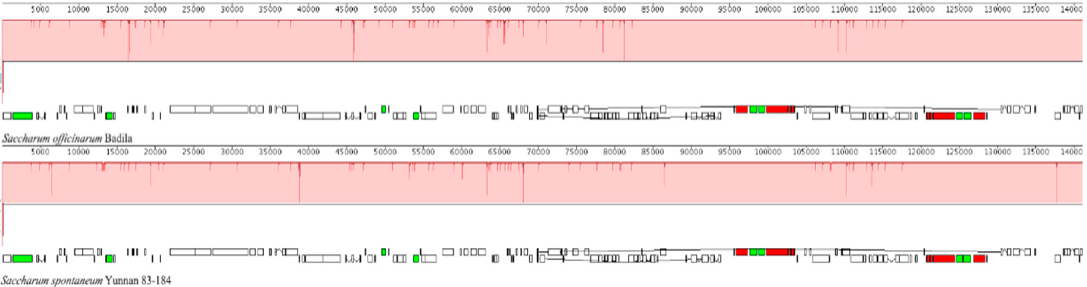
Figure 3. Colinear analysis of chloroplast genomes between two sugarcane ancestors Saccharum officinarum and S. spontaneum . Color bands represent genes, and di ff erent colors represent di ff erent blocks. Blocks with the same color between di ff erent genes represent homologous regions. Within each block, Mauve software draws similar profiles of genome sequences, and the height of similar profile corresponds to the average conservative level of the sequence region of the genome. Two rows of small blocks below the color band represent genes. The top one is on the positive chain, and the below one is on the complementary chain. Of which, the white block represents the CDS, a thin line inside the white blocks denotes intron. Green and red blocks represent tRNA and rRNA, respectively.